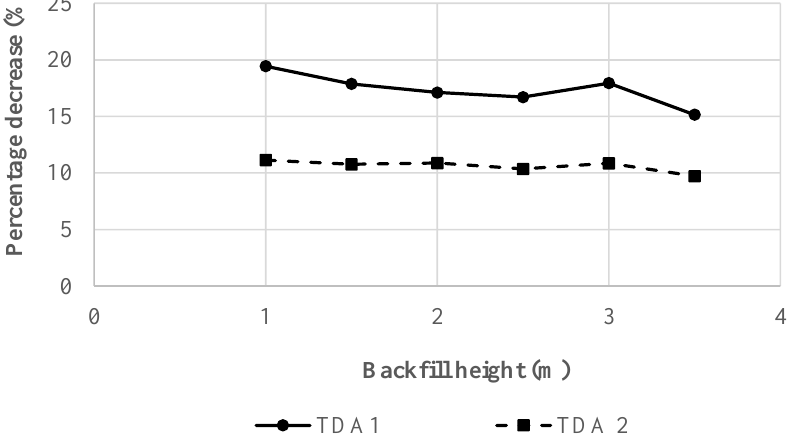
Figure 10. Percentage decrease of the maximum bending moment using TDA 1 and TDA 2 trench configurations for the ML90 backfill.